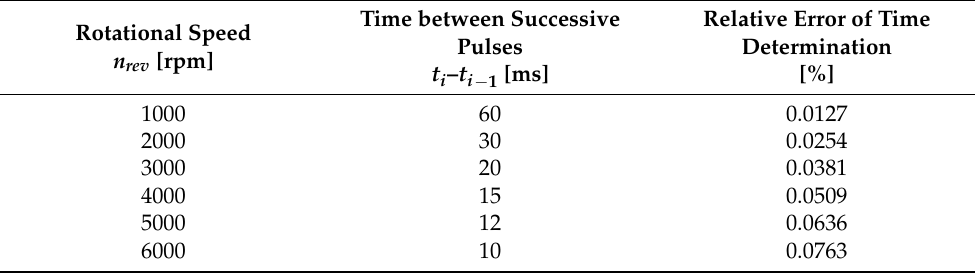
Table 1. Relative error values in determining time between successive pulses for the sensor of the top dead center of the piston.